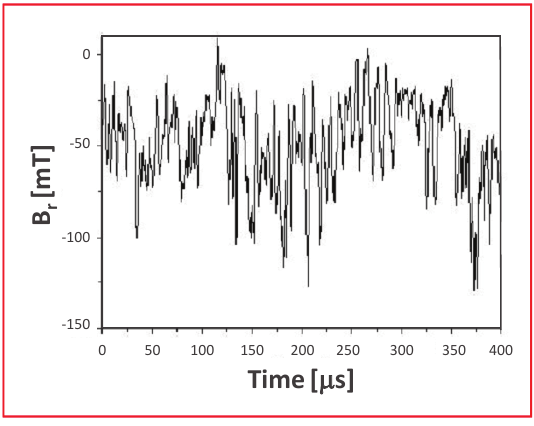
Figure 10: Turbulence as measured at the external wall of a device designed for thermonuclear fusion, namely the RFX in Padua (Italy). The radial component of the magnetic field as a function of time is shown in the figure (courtesy by V.